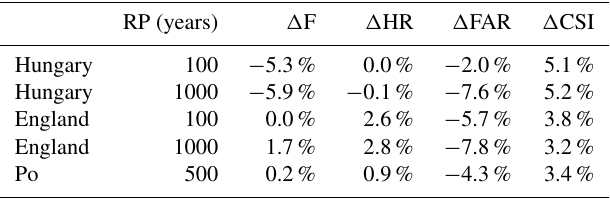
Table 9. Comparison of performances of the flood hazard maps described in the present study and developed by Dottori et al. (2016b) based on the MERIT DEM (a) and the CCM DEM (b). Table reports the ratio between flood extents F and the differences for HR, FAR and